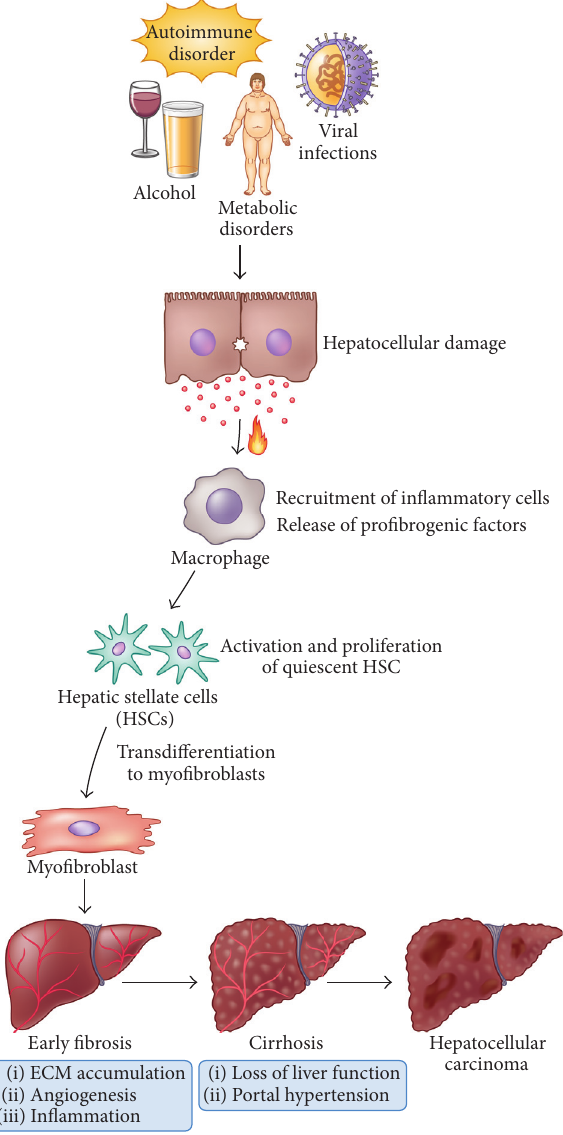
Figure 1: Hepatic injury initiated by chronic viral infections, exces- sive alcohol consumption, metabolic disorders, or autoimmune insult leads to the development of liver fibrosis. Hepatocellular damage instigates the recruitment of inflammatory cells and release of profibrogenic factors that result in the transdifferentiation of the resident quiescent liver fibroblast (hepatic stellate cells, HSCs) to the highly activated, proliferative, motile, and contractile myofibroblast phenotype. ECM accumulation, angiogenesis, and inflammation lead to progressive fibrosis ultimately culminating into cirrhosis associated with loss of liver function and portal hypertension, or hepatocellular